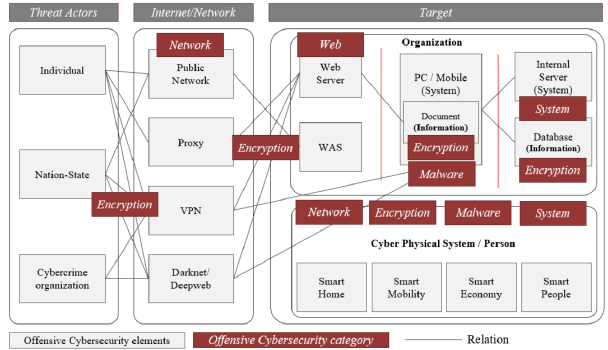
Figure 2. Offensive cyber security framework